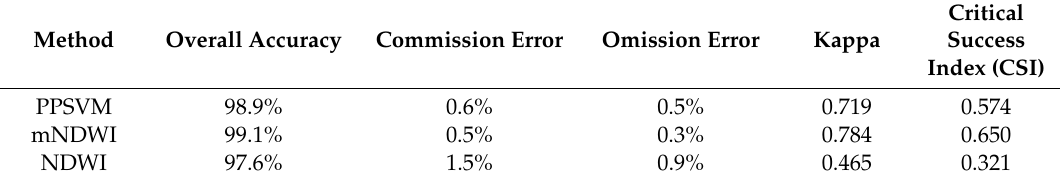
Figure 12. and Table 5 are the resulting maps and accuracy indices for the Yingluoxia reach.